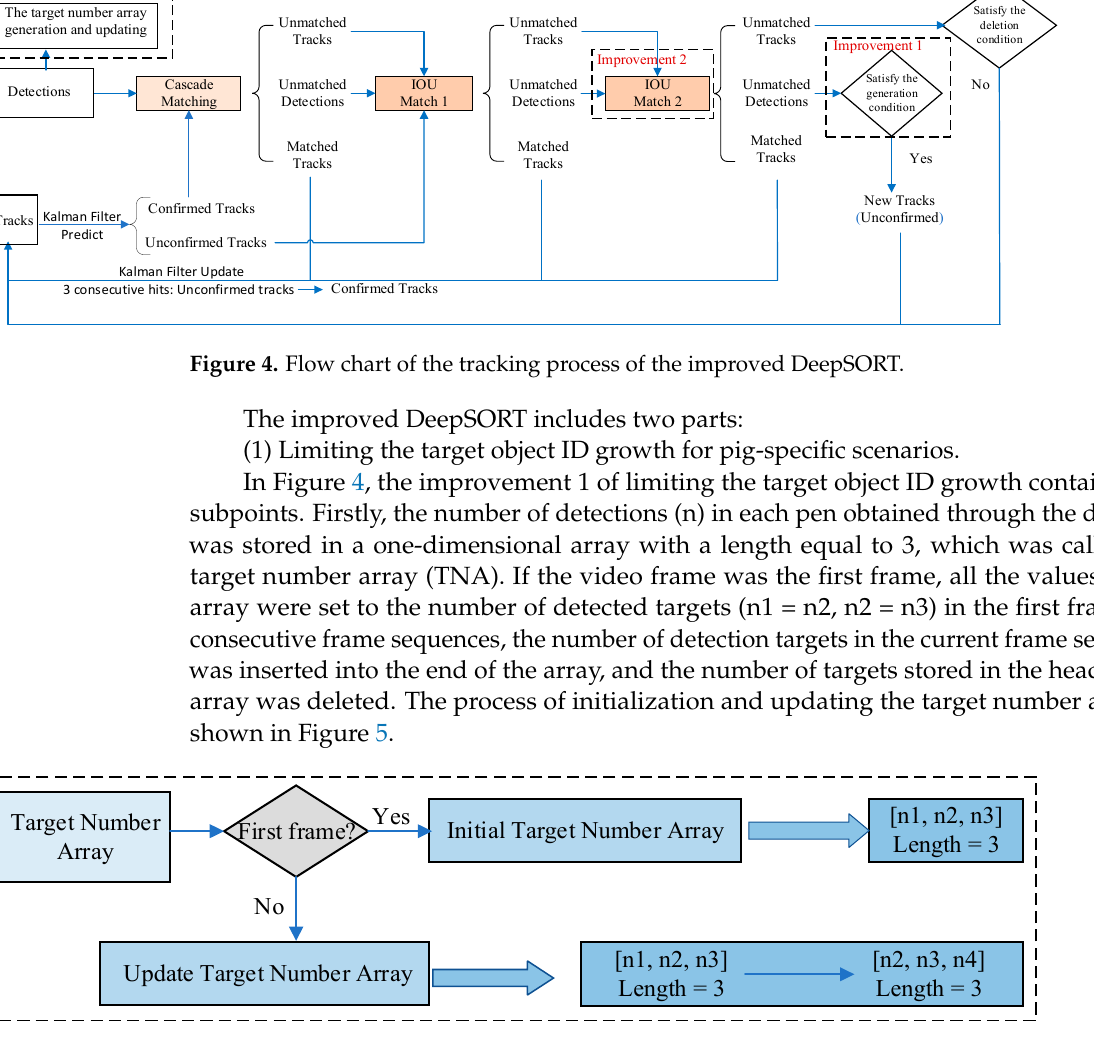
Figure 5. Initialization and updating of the target number